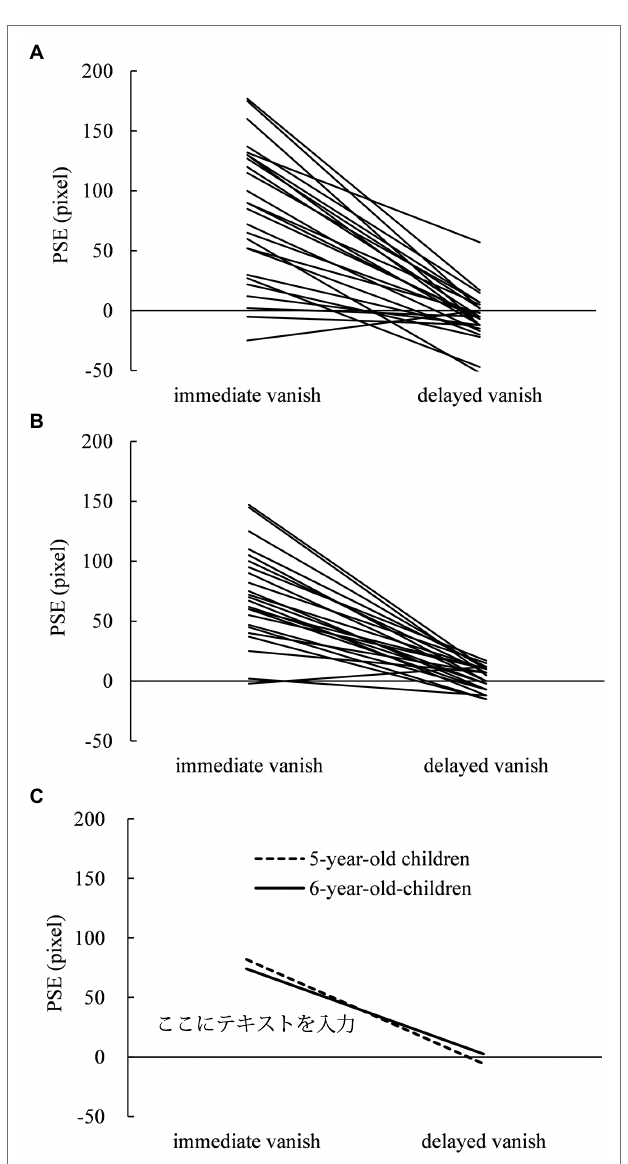
FIGURE 2 | Individual points of subjective equality (PSEs) in the judging task under the immediate- and delayed-vanishing conditions in (A) 5-year-old children and (B) 6-year-old children with (C) mean PSEs for both.